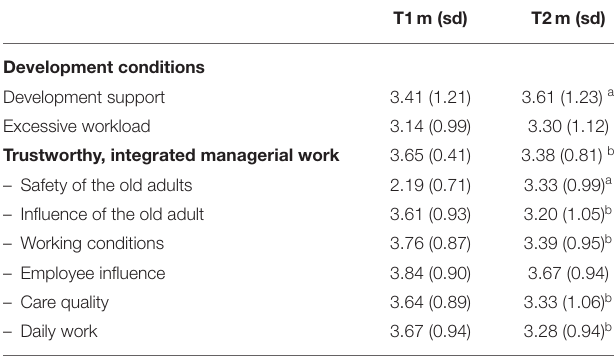
TABLE 3 | FLM-assessed conditions for development and ability to conduct trustworthy, integrated managerial work before COVID-19 (T1) and 16 months into the pandemic